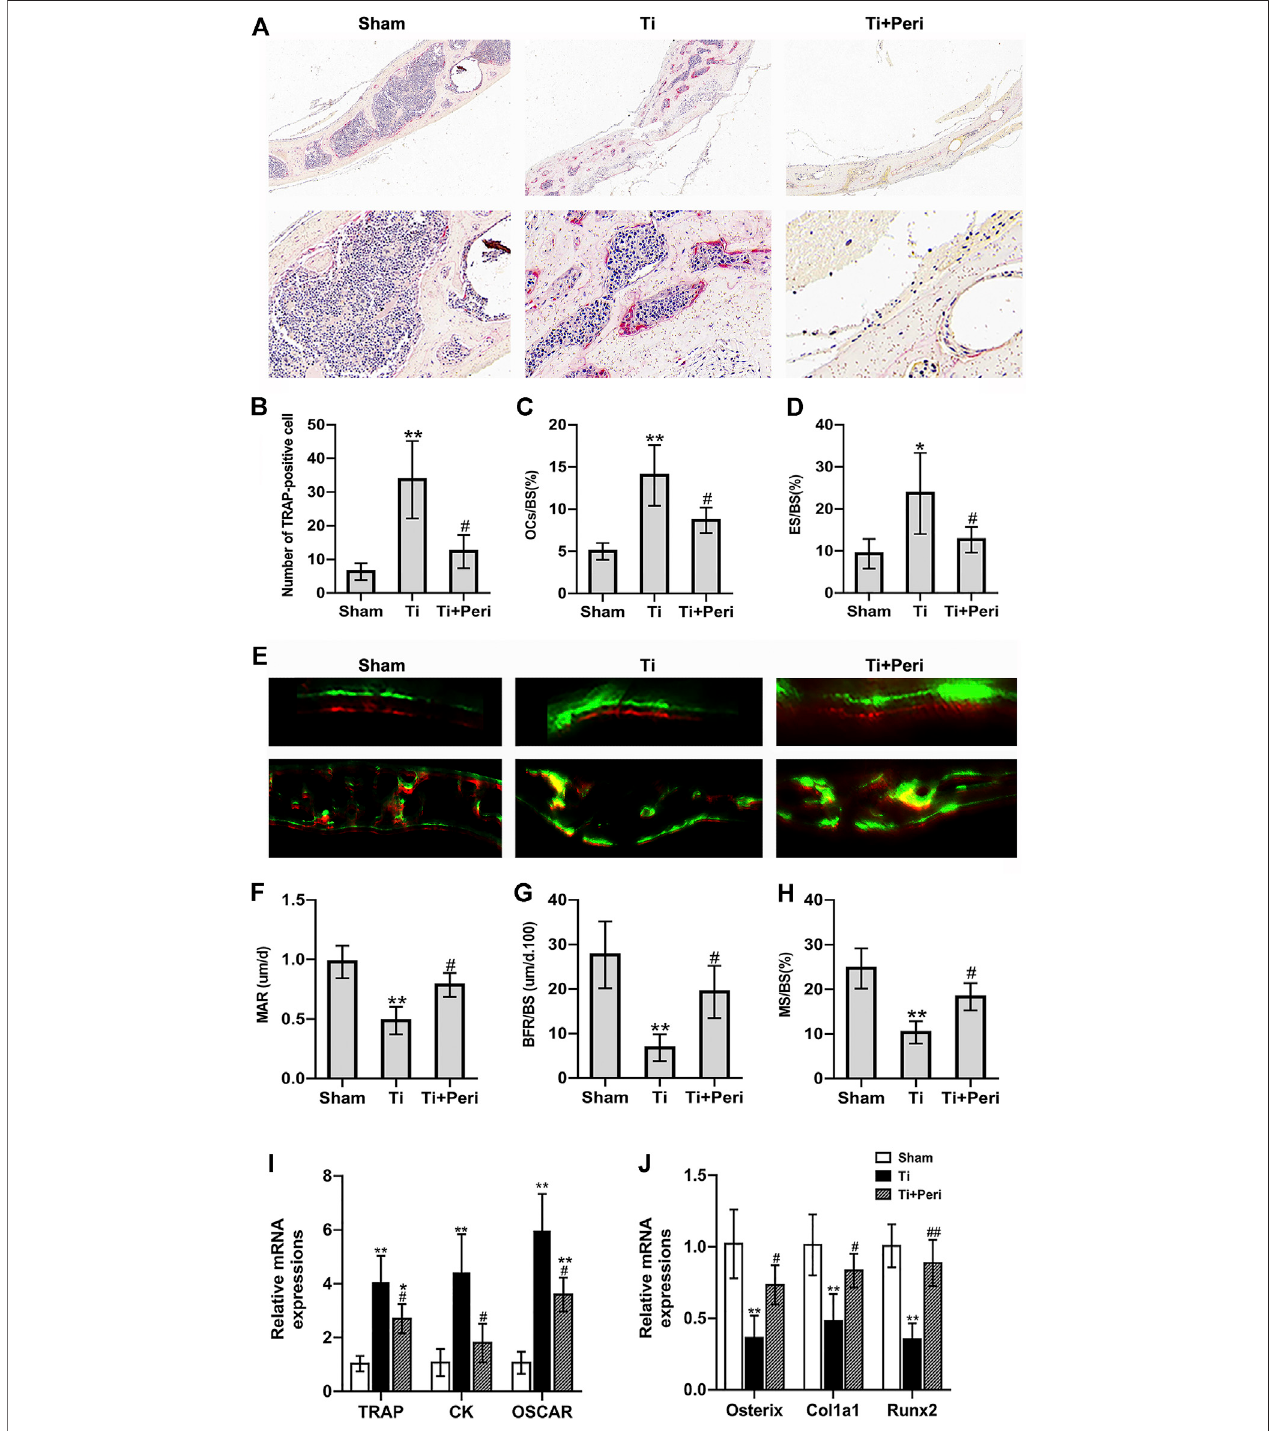
FIGURE 4 | Inhibition of ACE ameliorated Ti-particle-induced increase in bone resorption and decrease in bone formation in a murine calvarial osteolysis model. Data are representative images or expressed as the mean ± SD of each group from three separate experiments ( n (cid:1) 3 per group). (A) Representative TRAP staining images (magni fi cations × 100 and × 400). (B) Quantitative analyses of the number of TRAP-positive cell. (C) Quantitative analyses of OC.s/BS (%). (D) Quantitative analysesofES/BS(%). (E) Representative fl uorescence calcein andalizarinred labelling images (magni fi cations × 100and × 400). (F) Quantitativeanalysesofmass parameters, including mineral apposition rate (um/d). (G) Quantitative analyses of BFR/BS (um/d.100). (H) Quantitative analyses of mineralizing surface to bone surface (%). (I) RT-qPCR analyses of the relative levels of osteoclast-speci fi c genes (TRAP, CK, and OSCAR) in mice calvarial tissue to the control GAPDH expression. (J) RT- qPCR analyses oftherelativelevels ofosteoblast-speci fi cgenes(Osterix, Col1a1,and Runx2)inmice calvarialtissue tothecontrolGAPDHexpression. * p < 0.05vs. the sham group; ** p < 0.01 vs. the sham group; # p < 0.05 vs. the Ti group; ## p < 0.01 vs. the Ti group.